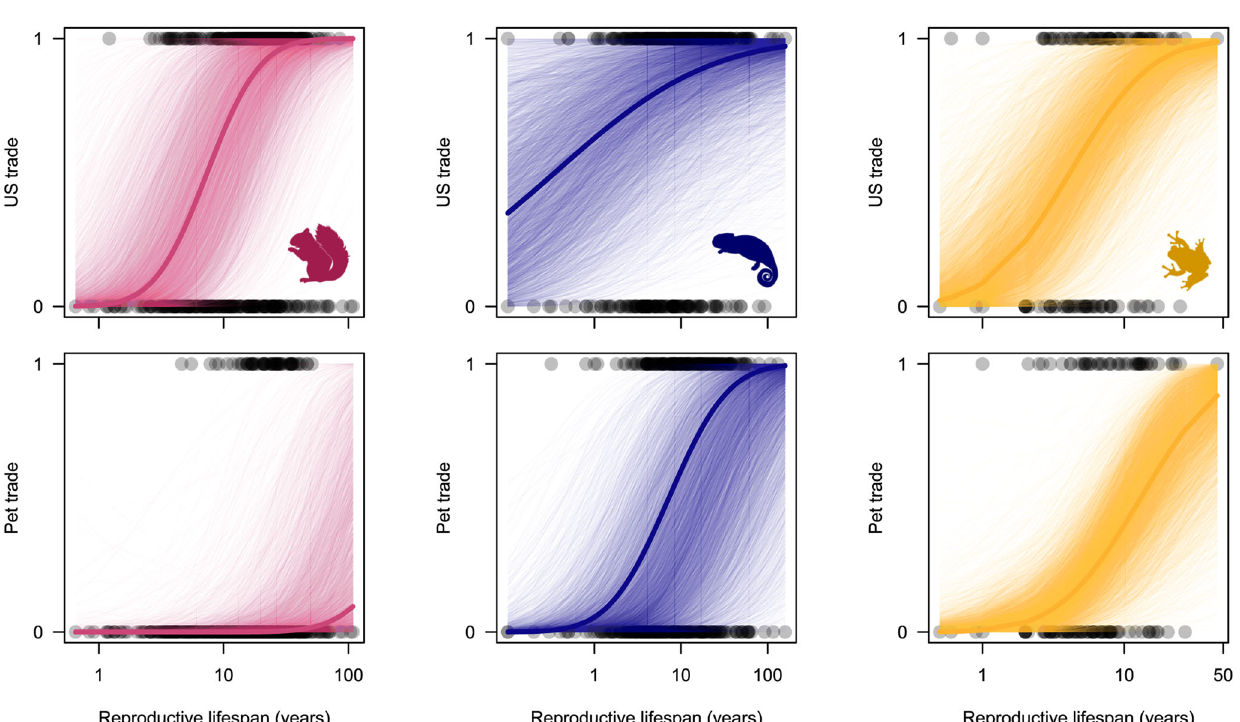
Fig. 2 | Model classi fi cation performance. Classi fi cation performance for models based on the US live wildlife trade data across mammal (pink), reptile (blue) and amphibian (gold) species using within-sample predictions (top row) and LOOCV (bottom row). Histograms show distributions of predicted probabilities for traded